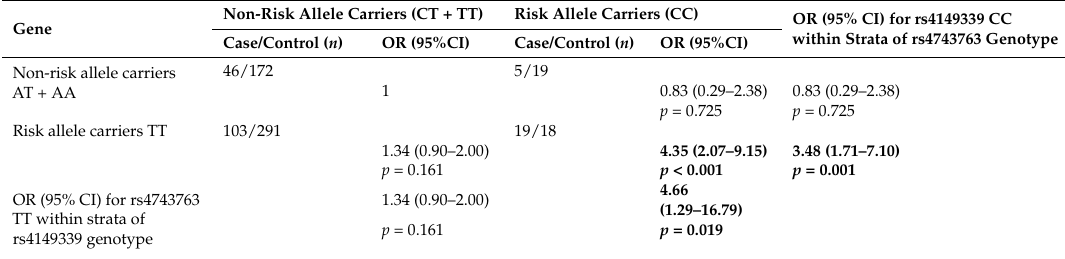
within Strata of rs4743763 GenotypeCase/Control ( n ) OR (95%CI) Case/Control ( n ) OR (95%CI)